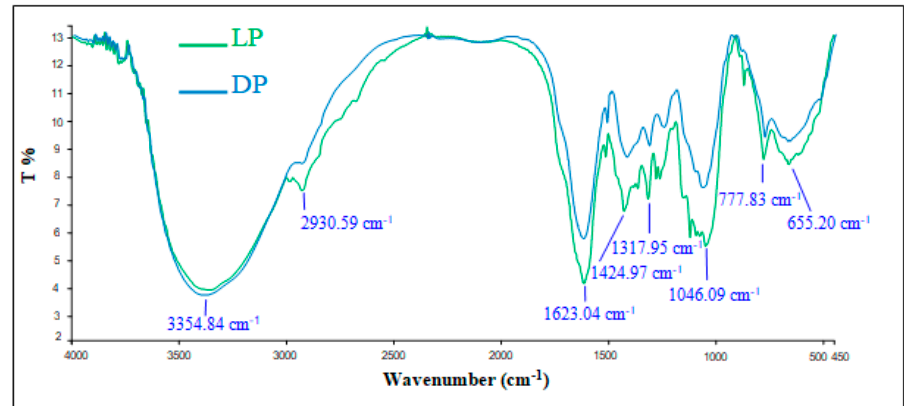
Figure 2. FTIR Spectra of two cactus formulations (LP and DP).